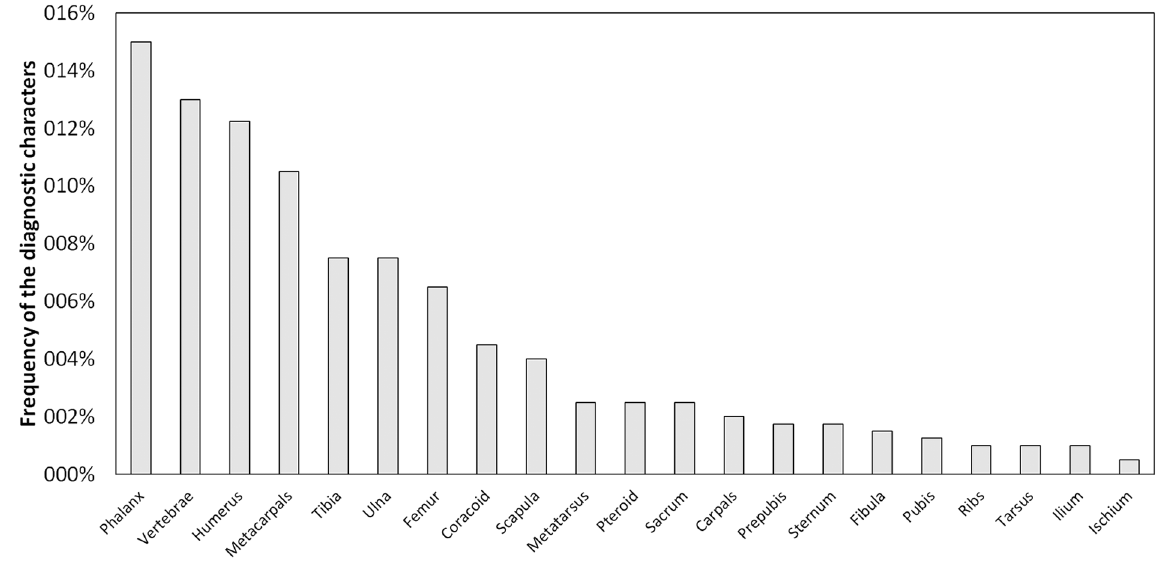
Figure 1. Frequency of post-cranial elements diagnosing new pterosaur